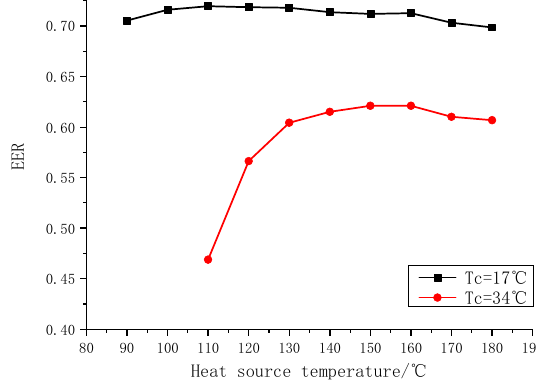
Figure 2. Effect of heat source and cooling water temperatures ( T c ) on system performance.